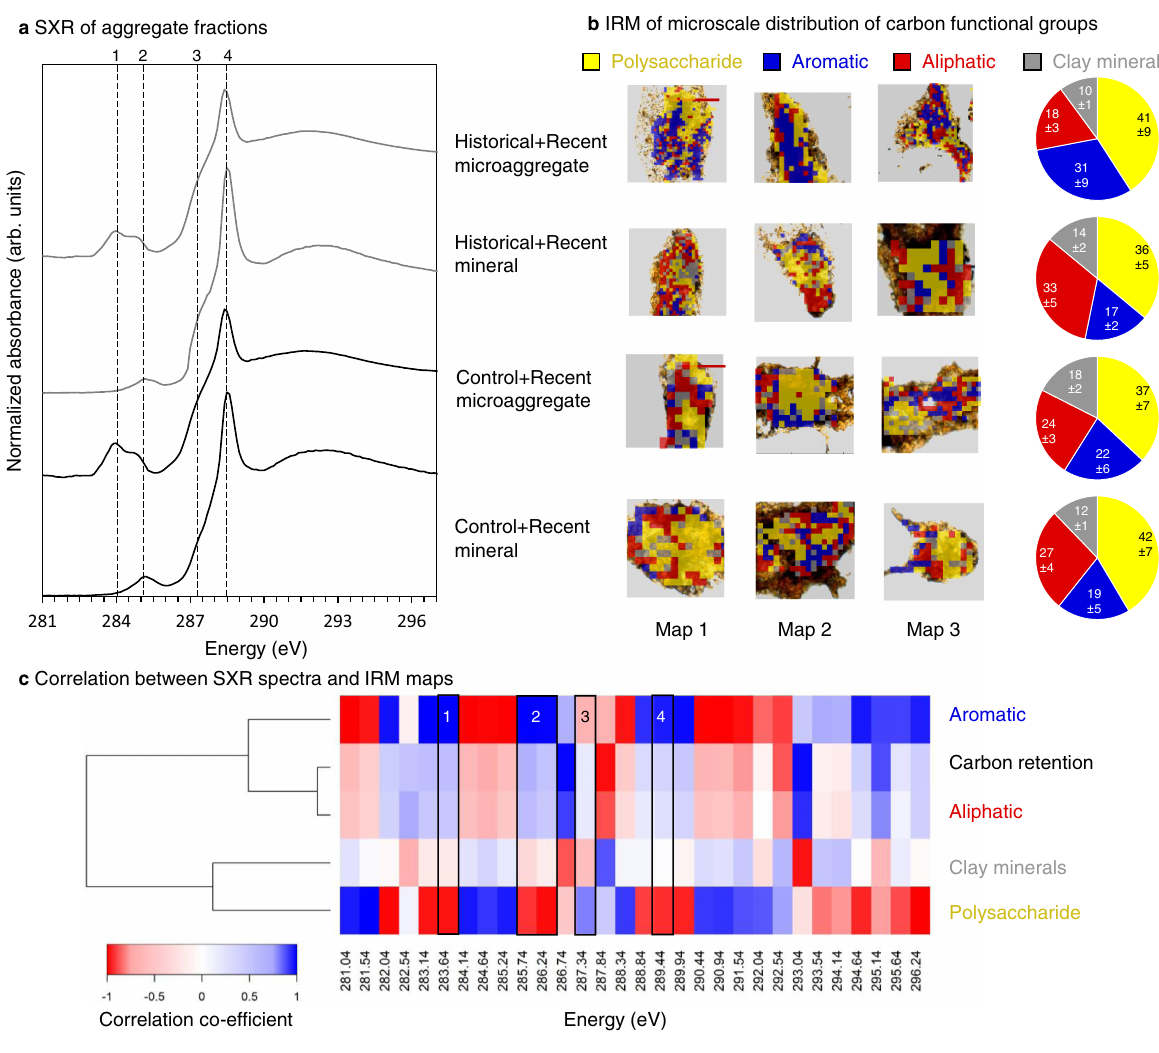
Fig. 5 | Synchrotron-based spectromicroscopic analysis of microaggregates (53 – 250 µ m) and mineral fractions (<53 µ m) in Control+Recent and Historical +Recent soils. a Average soft X-ray (SXR) spectra of microaggregates and mineral fractions from Historical+Recent and Control+Recent plots ( n =9, CV< 3%), fea- turing quinones, aromatic C, aliphatic C, and carboxylic C. b Semi-thin (200nm) sections of free water-stable microaggregates and mineral fractions isolated from Historical+Recent and Control+Recent plots analyzed using synchrotron-based infrared-microspectroscopy (IRM). Spectral maps showing the distribution of